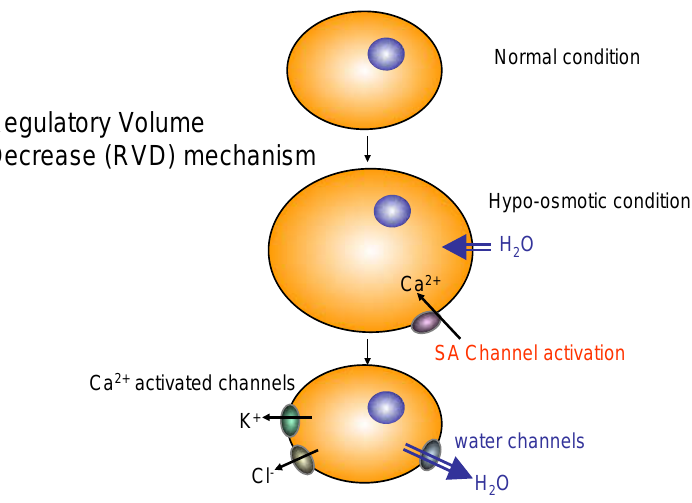
Figure 6. The role of water channels in cell volume regulation against osmotic shock. Acute cell volume regulation is mediated by the activation of membrane ion transporters and water channels. Regulatory volume decrease (RVD) is mediated by simultaneous activation of stress activated (SA) Ca 2+ channels, volume-sensitive potassium and anion channels and/or electroneutral K + , Cl − co-transporters. Volume-sensitive anion channels are permeable to Cl − and organic osmolytes (e.g., amino acids). Chronic hypo-osmolarity adaptation is accomplished by decreased expression of enzymes involved in osmolyte synthesis and a decrease in organic osmolyte